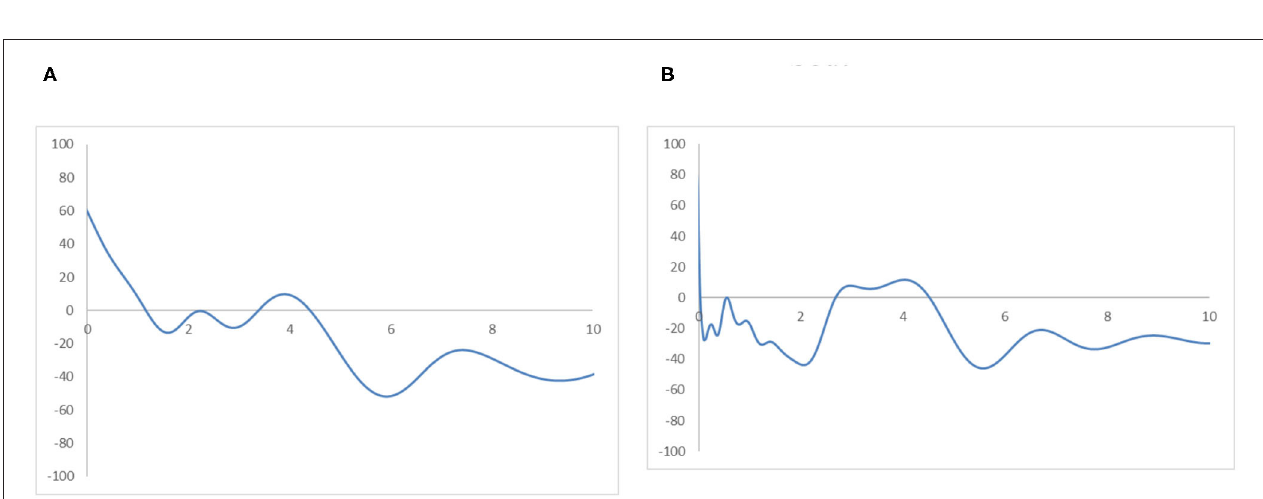
FIGURE 7 | Ergodic distributions for the RIVAPC of countries for the Global North and the Global South with annual transitions. Source: authors’ calculation. N.B. The vertical axis indicates the density of probability and the horizontal axis indicates RIVAPC values. (A) Global North. (B) Global South.